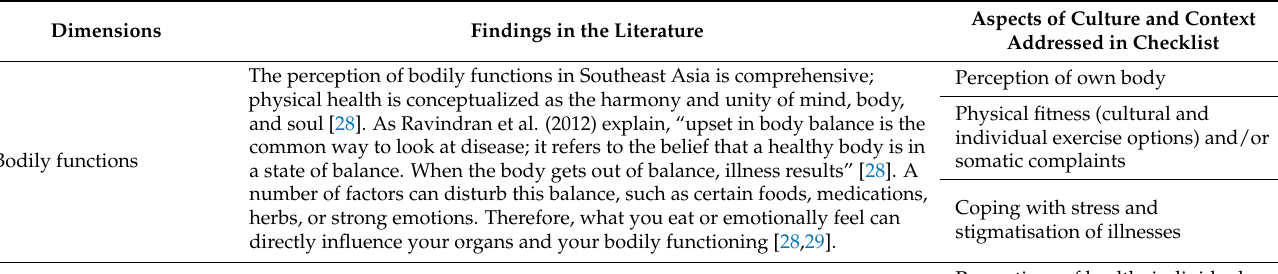
Table A1. Listing of the aspects of culture and context found in the literature review as addressed in the checklist, per dimension of ‘Positive